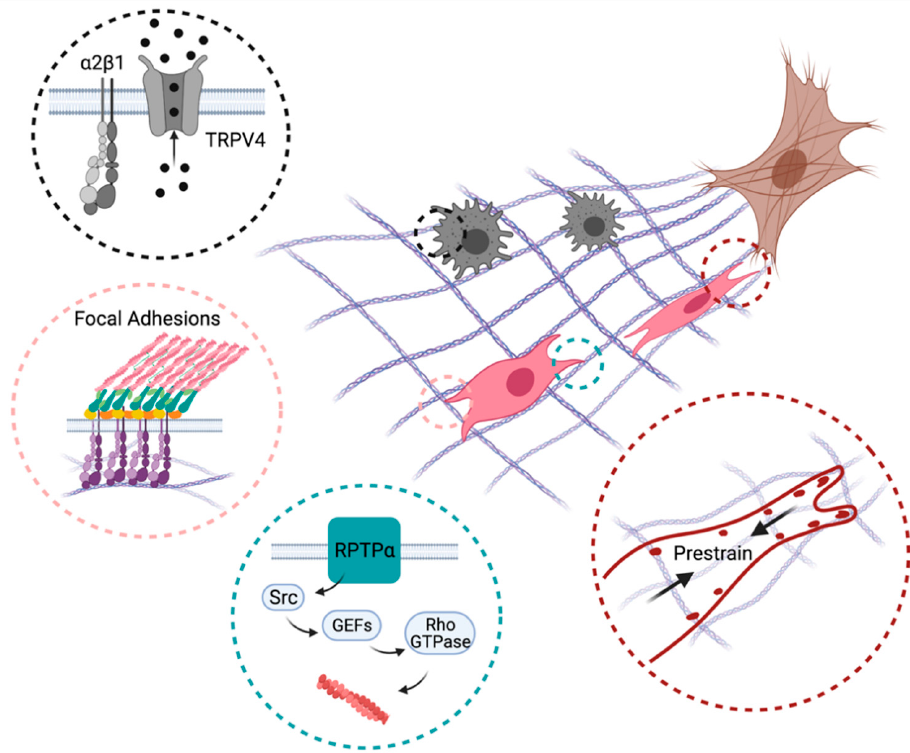
Figure 3. Mechanisms promoting directed immune cell and fibroblast migration towards inflammatory lesions (brown). Myofibroblast-induced collagen remodeling creates a gradient of ECM stiffness and alignment that recruits macrophages (black) and fibroblasts (pink) to the wound site. Black circle: α 2 β 1 integrins and mechano-gated ion channels such as TRPV4 enable macrophages to sense ECM deformation fields produced by contractile myofibroblasts. Pink circle: Mechanical interactions mediated by dynamics of integrin-based focal adhesions allow fibroblasts to migrate up the ECM stiffness gradient. Green circle: Signaling proteins (RPTP- α ) not directly involved in cell–ECM adhesion regulate directed migration through the actin cytoskeleton and cellular protrusions. Red circle: Fibroblasts prestrain collagen fibers through myosin contractility and adhesions to enable directed migration. Created with BioRender.com.